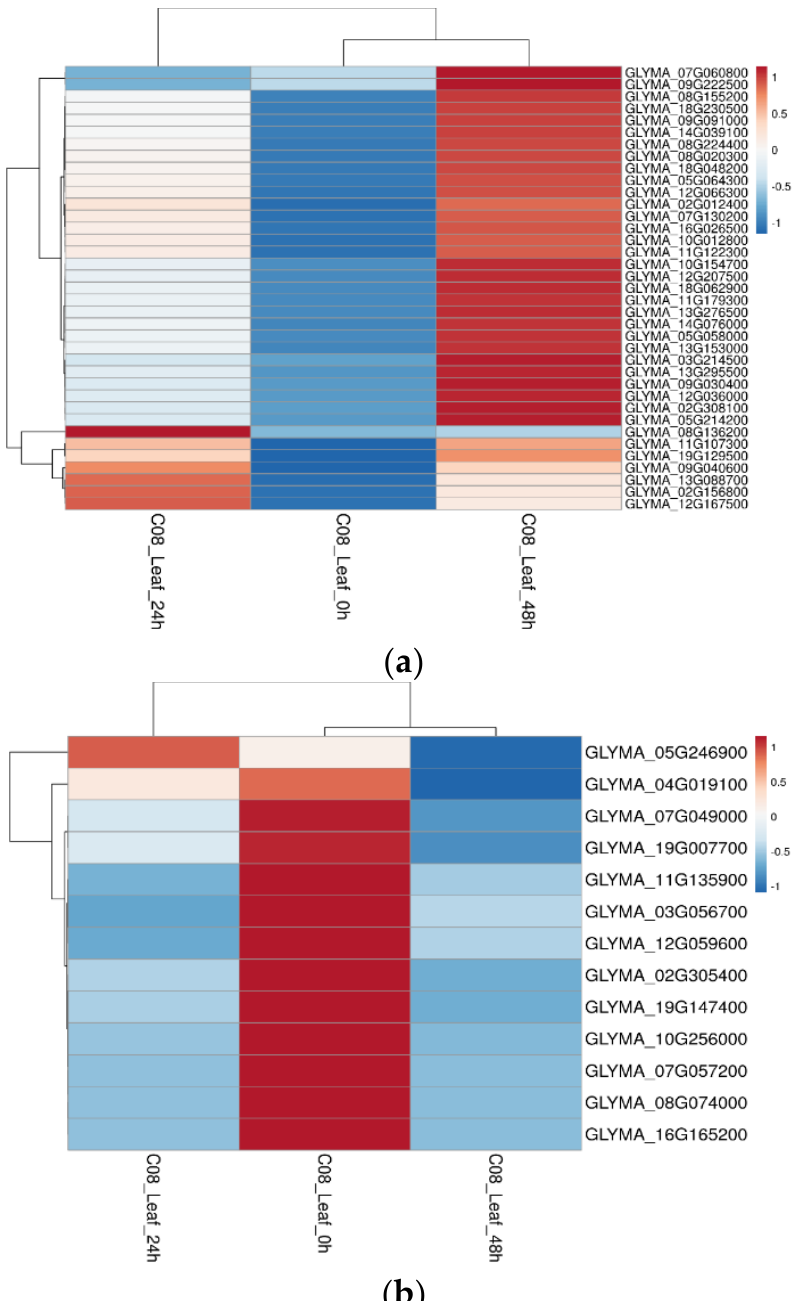
Figure 7. Gene expressions of up- and down-regulated membrane proteins in the leaf of soybean C08 upon salt treatment were consistent with the corresponding protein expression patterns. ( a ) Heat map of the gene expressions of key up-regulated membrane proteins in the leaf based on RPKM (reads per kilobase million mapped reads) values extracted from the published C08 transcriptomic data on the effects of 24 or 48 h of 150mM NaCl treatment [20]. ( b ) Heat map of the gene expressions of down-regulated membrane proteins in the leaf based on RPKM values extracted from the published C08 salt treatment transcriptomic data [20]. Red bars represent up-regulated gene expressions and blue bars represent down-regulated gene expressions of the corresponding differentially expressed proteins from this study. White bars represent unchanged gene expression